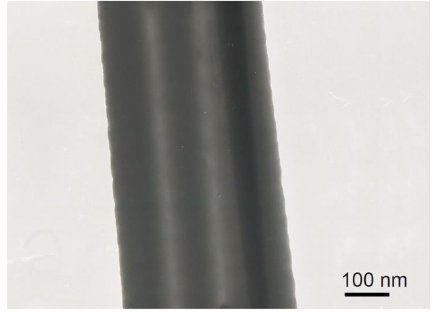
Figure 4. TEM image of PAN-epoxy-curing agent core-shell